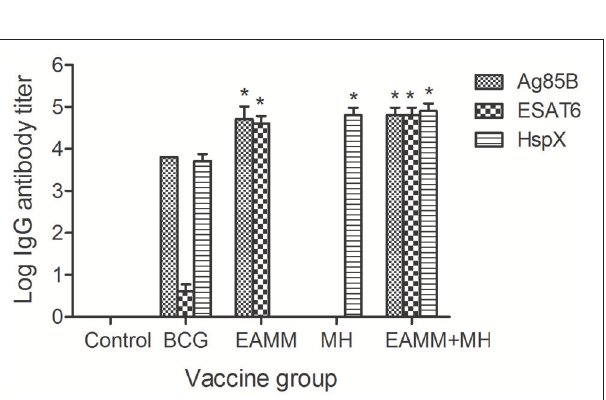
FIGURE 2 | Titers of antigen-specific IgG antibodies in the vaccinated groups. About 6-weeks after last vaccination, sera from all three rabbits in each group were obtained and the titers of ESAT6-specific, Ag85B-specific, and HspX-specific IgG antibodies were determined. Each column depicts the corresponding antigen-specific IgG antibody titer. * P < 0.01, relative to saline control and BCG